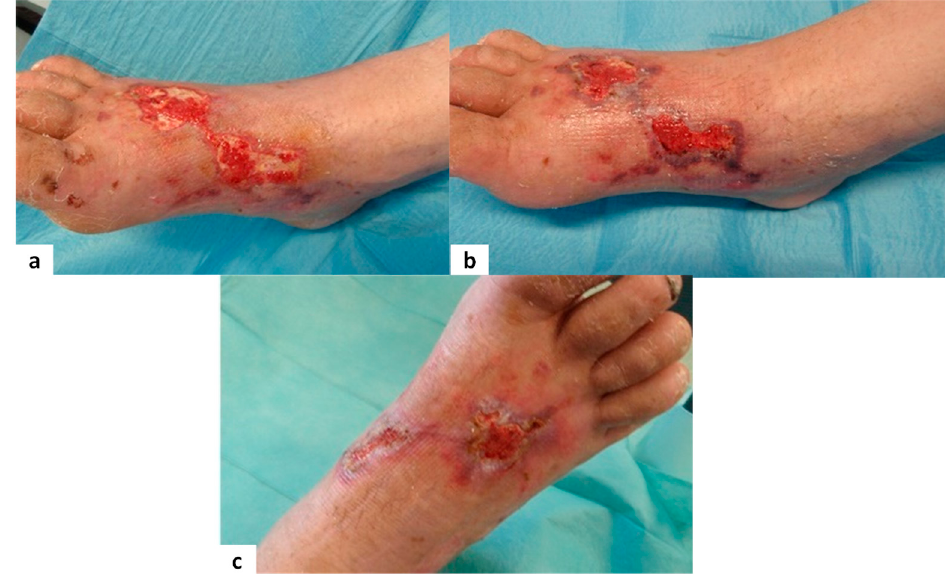
Figure 6. Case Group D. SA, 45 y/o. affected by diabetes and dyslipidemia reported a chronic loss of substance in the dorsal aspect of the right midfoot after crash injury. The aspect of the wound ( a ) at V1. Wound appearance in V4 ( b ). Final wound aspect two weeks after V5 ( c ).